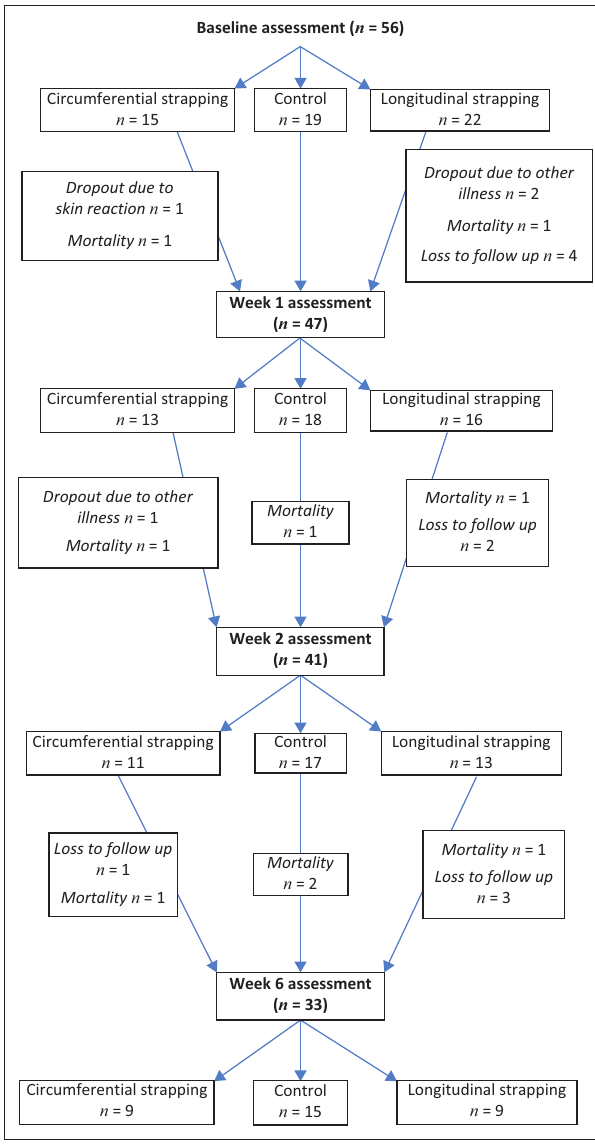
FIGURE 3: Flowchart showing participant recruitment and